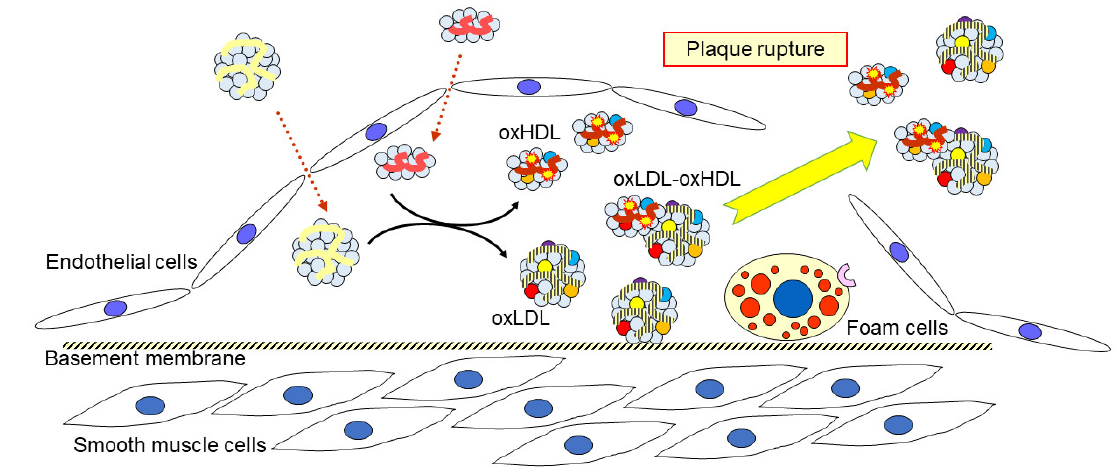
Figure 3. A proposed behavior of oxidized lipoproteins in atherosclerotic lesions and circulation. When LDL is oxidatively modified, HDL can interact with oxLDL to attenuate oxidative modification of LDL; in turn, HDL is modified to form oxHDL. A part of oxHDL may be associated with oxLDL. These oxidatively modified lipoproteins accumulate in vulnerable plaque and are released into the circulation when the plaque ruptures.